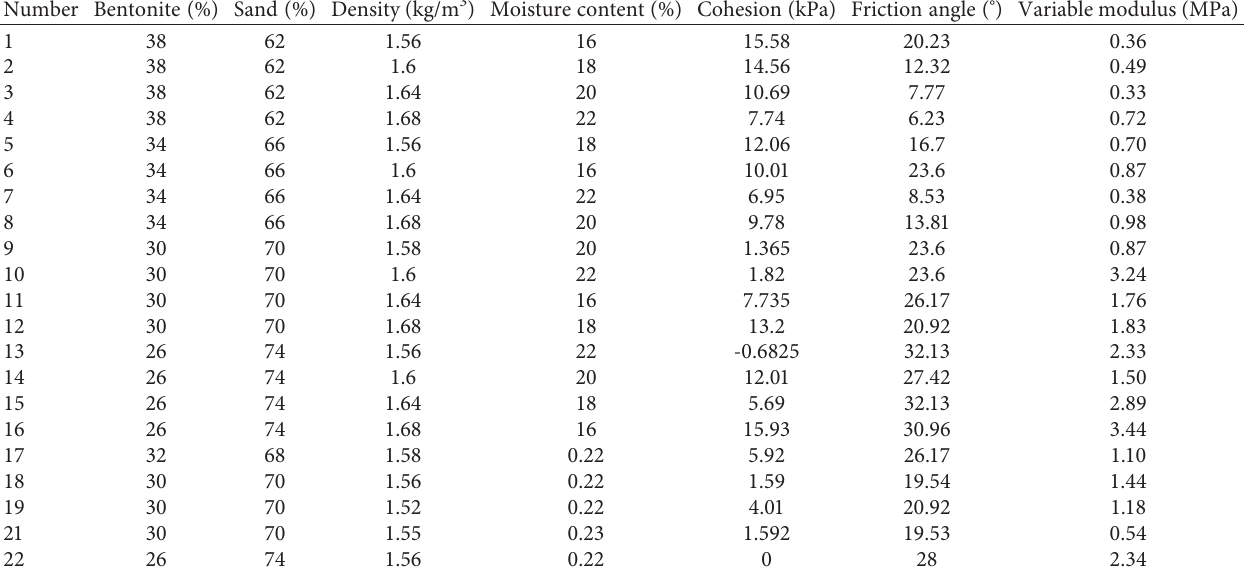
Table 2: Proportions and properties of similar